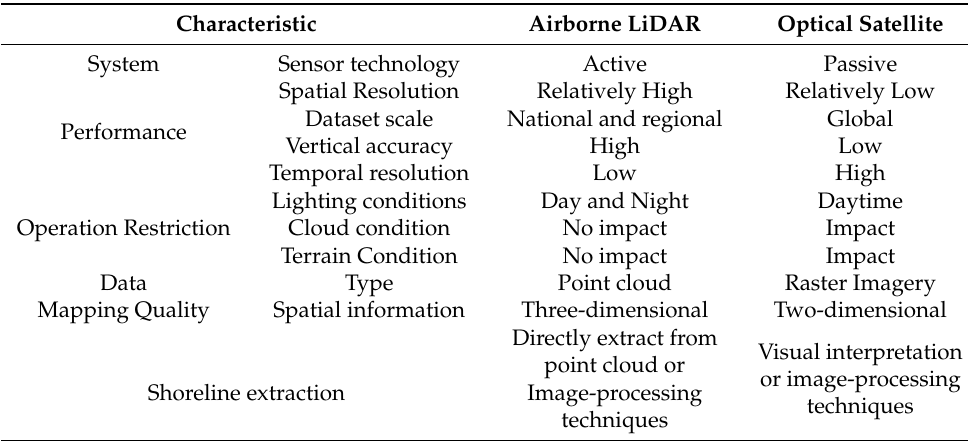
Table 1. Comparison of airborne LiDAR and optical satellite remote sensing. Characteristic Airborne LiDAR Optical Satellite System Sensor